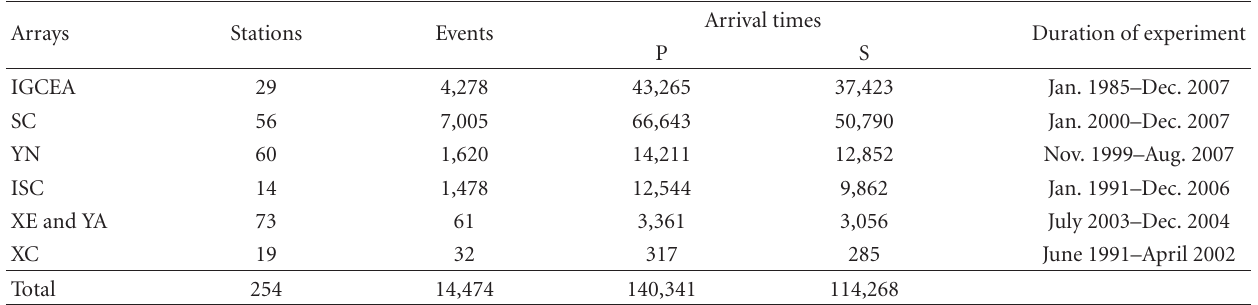
Table 2: Seismic stations and relative arrival times from teleseismic events (see text for details).